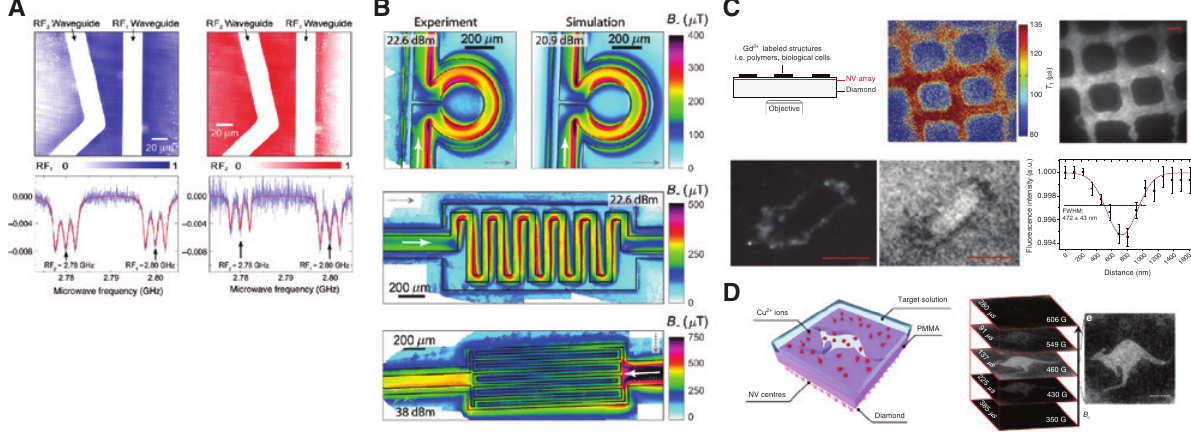
Figure 17: Examples of GHz-frequency QDM AC magnetic imaging. (A) Imaging the presence of MW field through the contrast and linewidth of the ODMR. (Reprinted with permission from Ref. [62]). (B) High spatial and temporal resolution Rabi imaging. (Reprinted with permission from Ref. [63]). (C) T and a Gd 3 + labeled cell membrane. (Reprinted with permission from Ref. [64]). (D) Demonstration of T sensitivity to the bias magnetic field